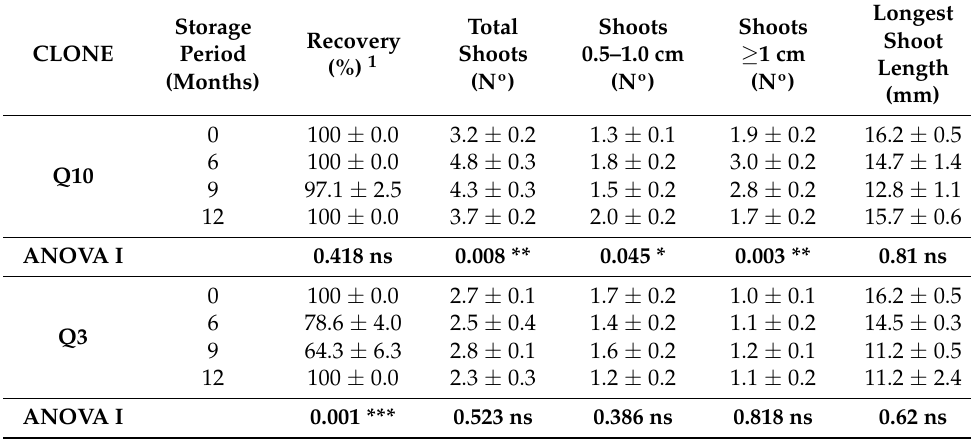
Table 5. Effect of cold storage period on recovery and proliferation capacity of shoot cultures derived from 7 adult Q. ilex